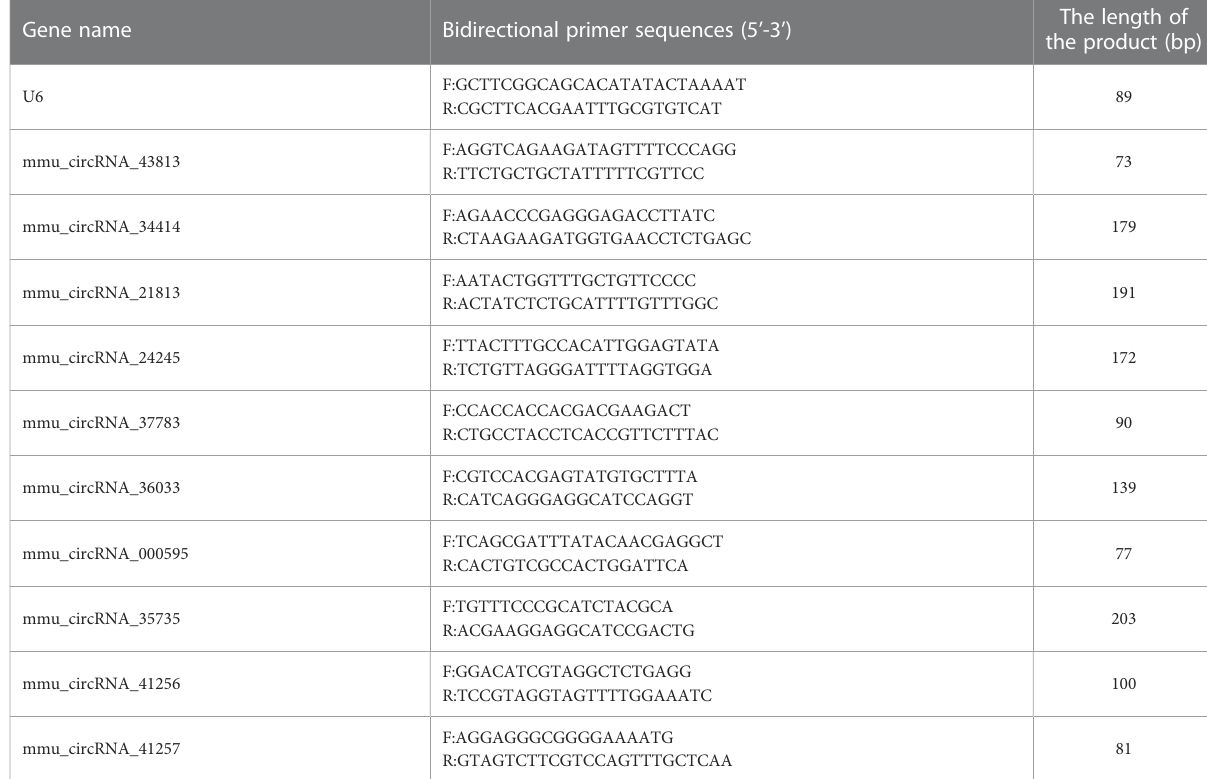
TABLE 1 The primer list was used for real-time quantitative